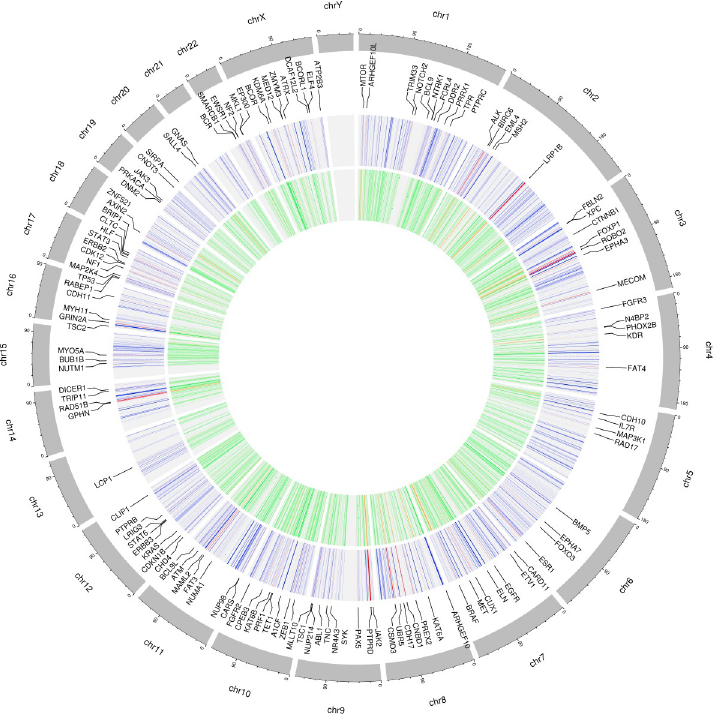
Fig 2. Mutated genes of interest. Circos plots showing the distribution, across the human genomes, of the 3700 pre- selected genes (inner circle) commonly mutated BRCA-US, OV-US, and PRAD-US cancer data sets, including COSMIC (orange) and non-COSMIC (green) genes (red); The second circle from the middle shows the 1537 cancer- causing candidate genes, with non-COSMIC genes in blue, and COSMIC genes in red labeled with their gene names.